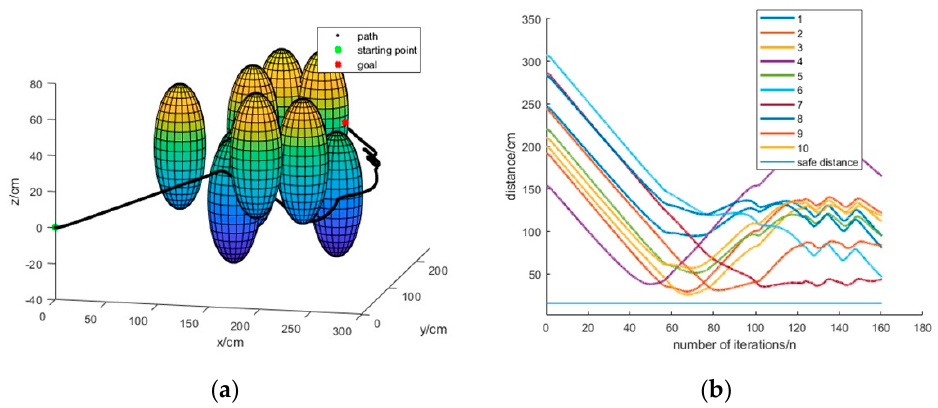
Figure 14. Case without time step in group 2. ( a ) Path planning of 3D map. ( b ) The distance from obstacles.